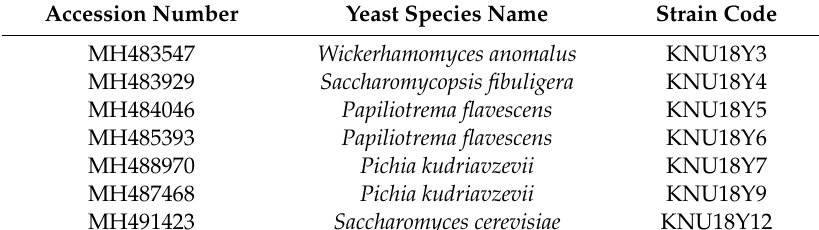
Table 4. The accession number of the identified yeasts species and strain code.